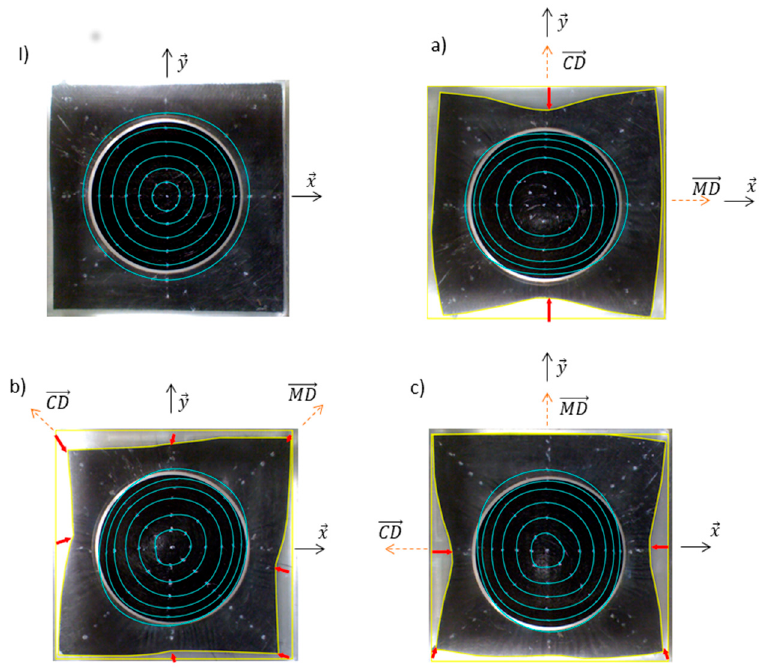
Table 2. Characteristics of the deformed ellipse on preformed samples.